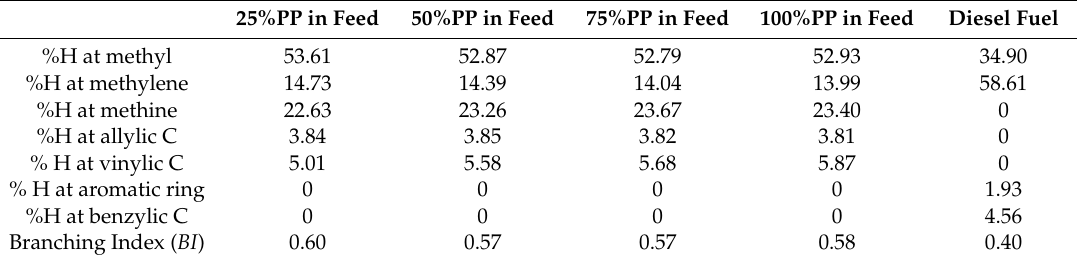
Table 1. H-NMR analysis results of non-polar fractions of bio-oil obtained from co-pyrolysis at various PP compositions. 25%PP in Feed 50%PP in Feed 75%PP in